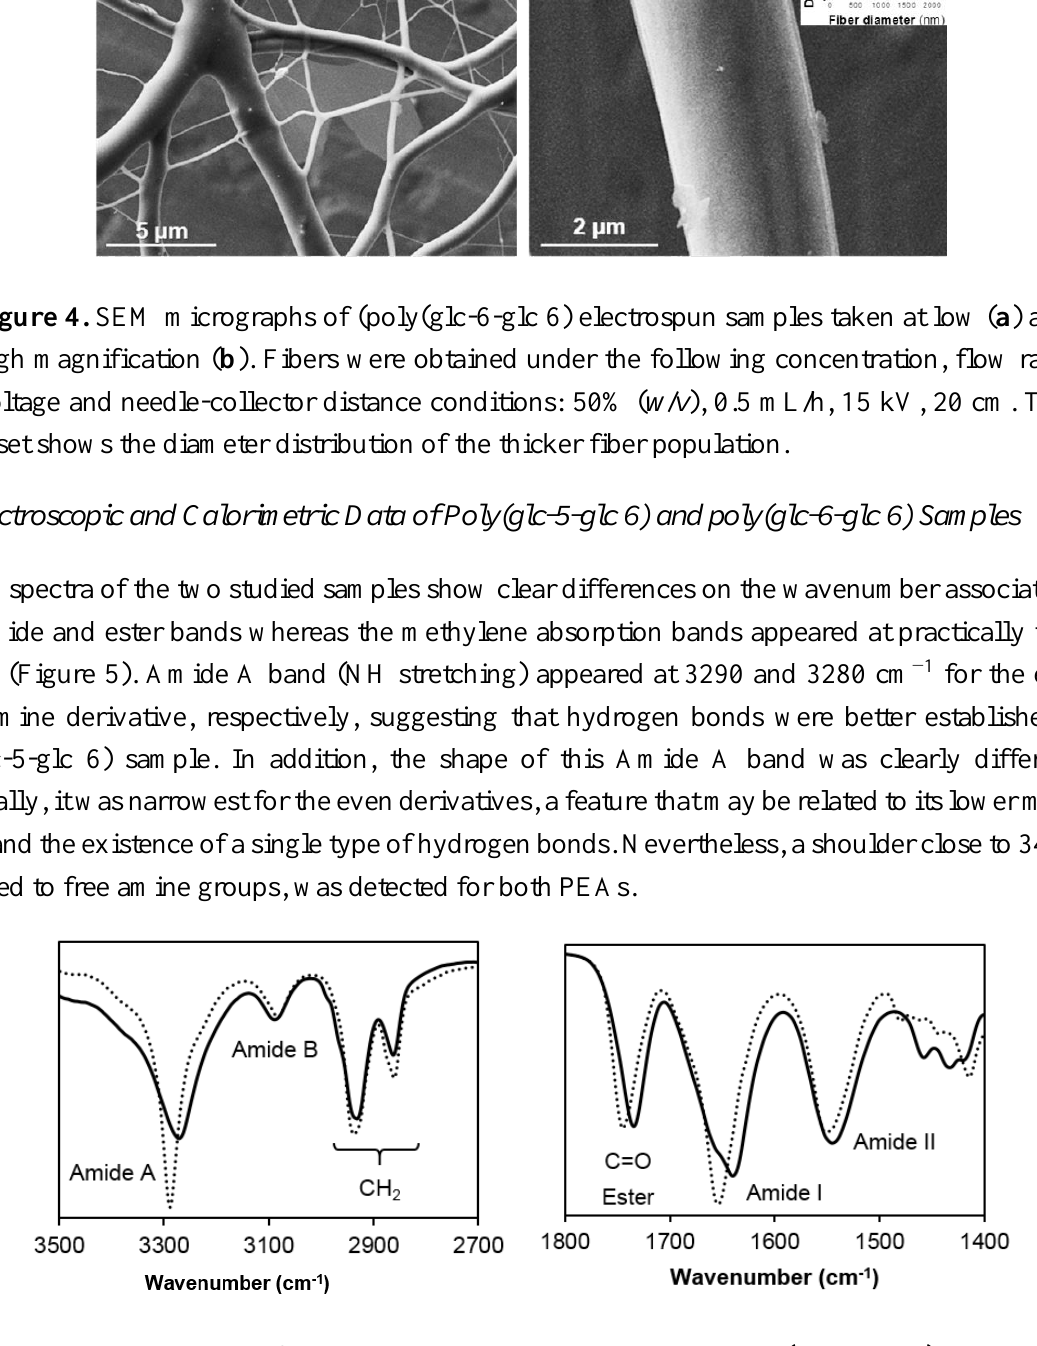
Figure 5. FTIR spectra of the two synthesized homopolymers: Poly(glc-5-glc 6) shown as a continuous line and (poly(glc-6-glc 6)) as a dotted